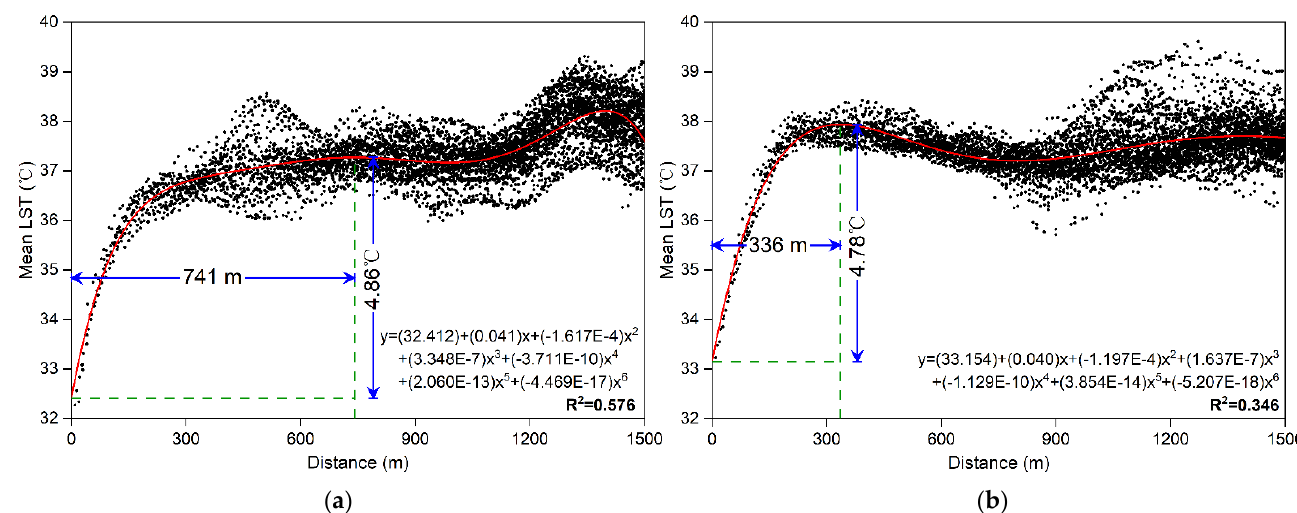
Figure 6. Mean LST at different distances to ( a ) West Lake in Hangzhou and ( b ) Xuanwu Lake in Nanjing. The scatter diagrams showed the relationships between LST and the distance to the water bodies intuitively but not quantitatively. Based on the above-mentioned affecting scale, multiple linear regression models were established to present the relationships quantitatively, and the significance tests were listed in Tables 4 and 5. The models for